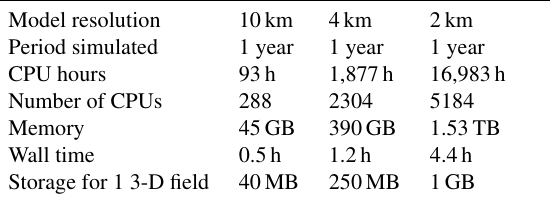
Table 1. Computational requirements at different resolutions. WAOM has been run on the supercomputer Gadi from the Na- tional Computing Infrastructure (NCI) in Australia. The architec- ture consists of 2 × 24-core Intel Xeon Platinum 8274 (Cascade Lake) 3.2GHz CPUs per node with 192GB RAM per node. Listed times are for time stepping only, which is without initialisation or